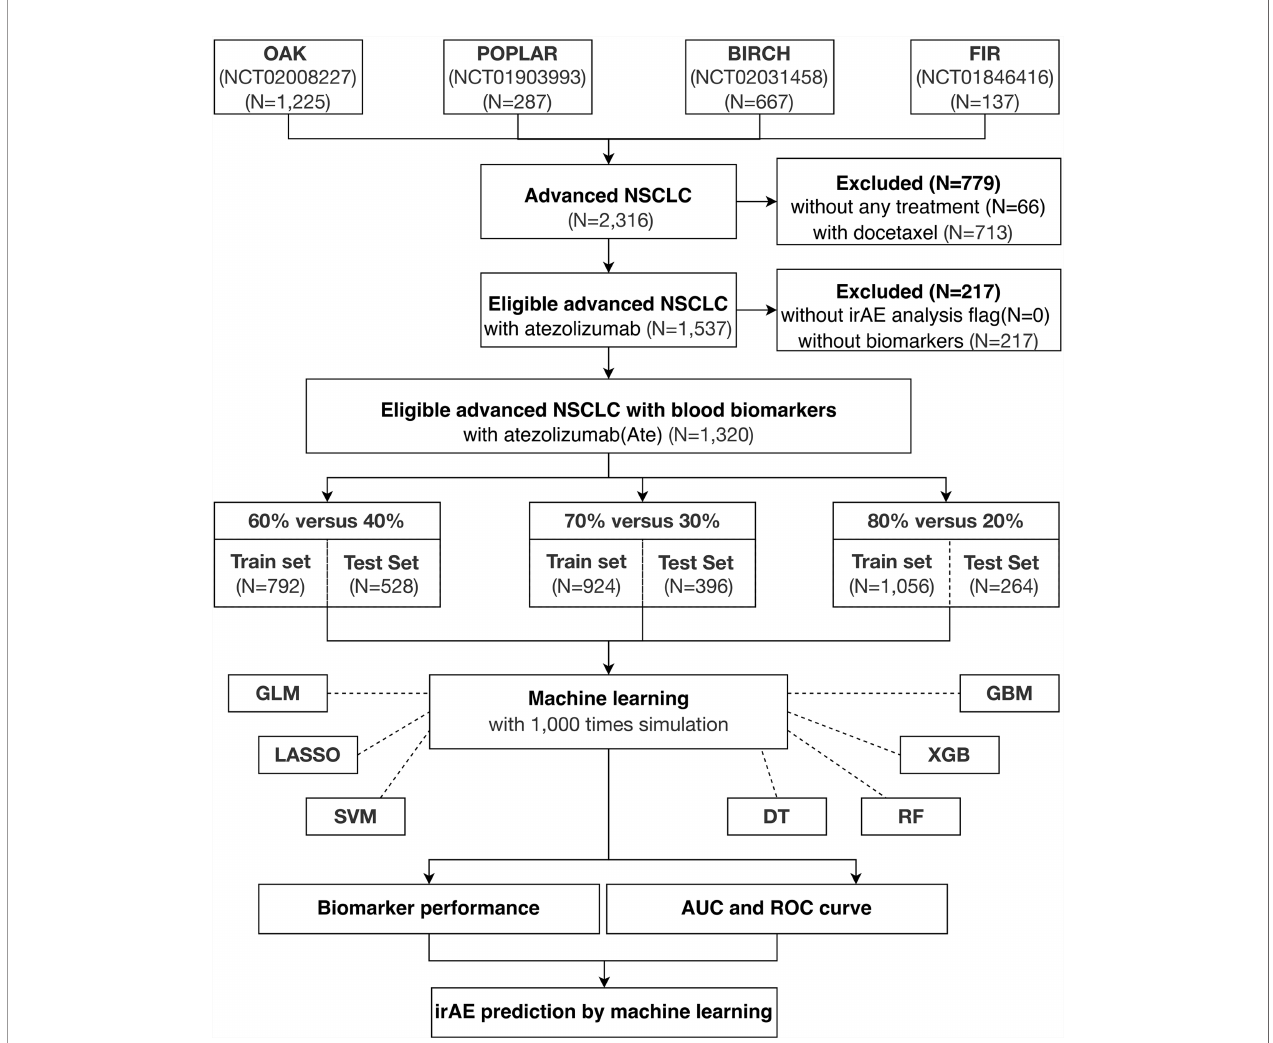
FIGURE 1 | Study overview. A total of 1,320 eligible NSCLC patients undergoing atezolizumab single-agent treatment is obtained from four international, multicenter clinical trials for this